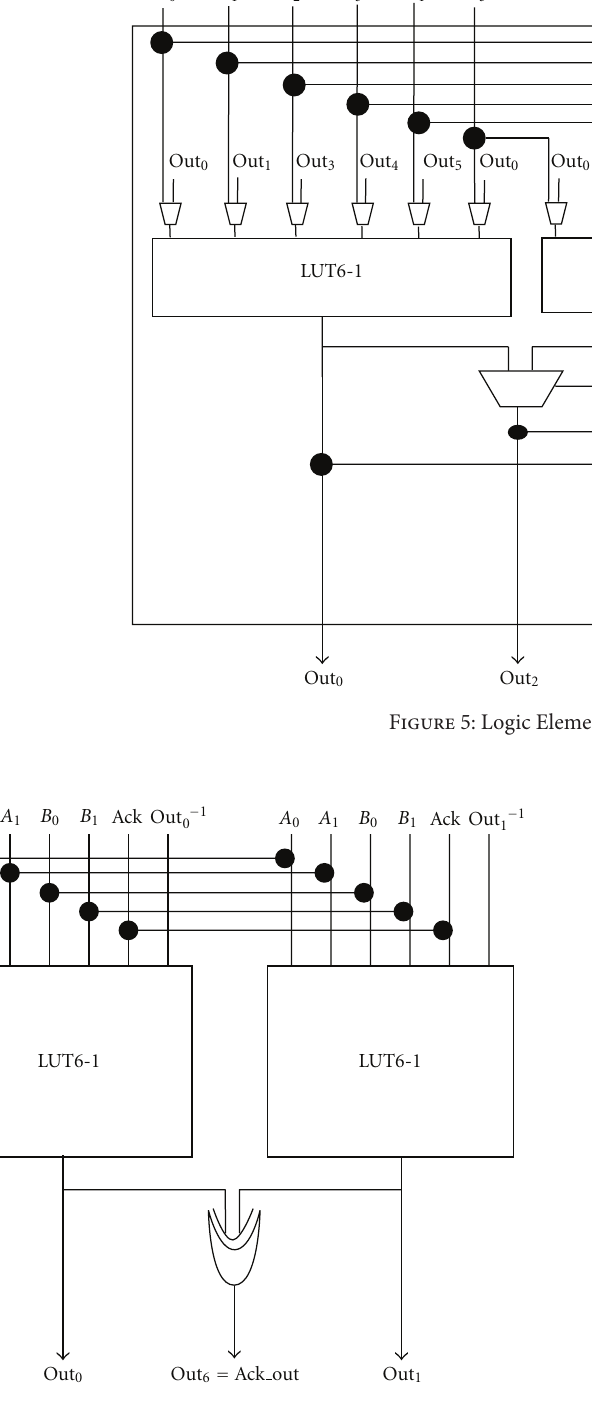
Figure 6: 2-input dual-rail gate implementation.